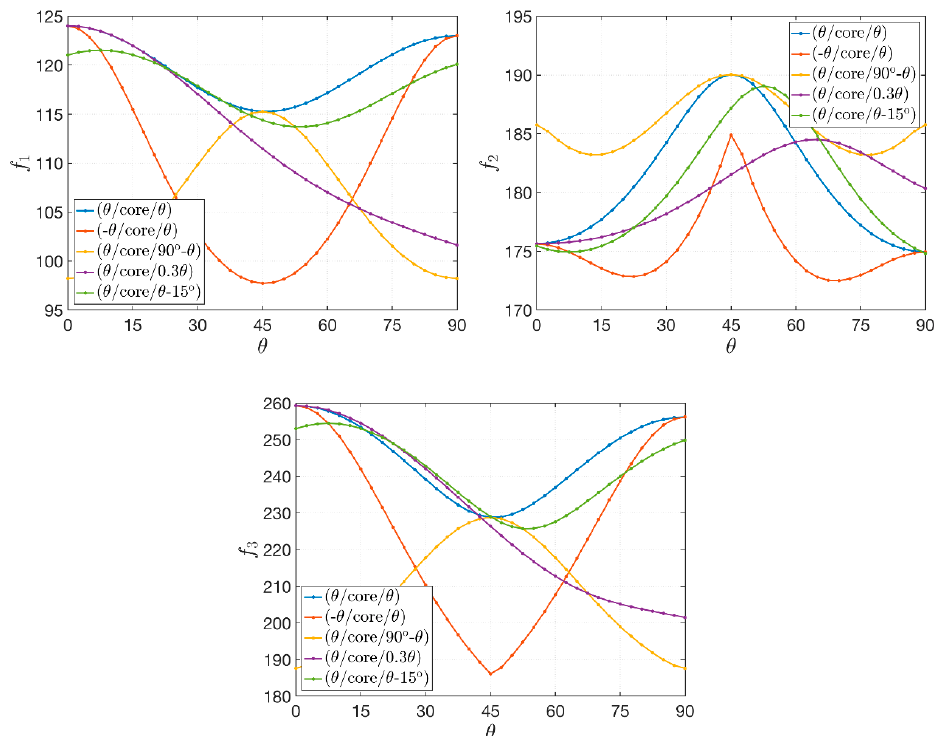
Figure 8. Variation of the first three natural frequencies